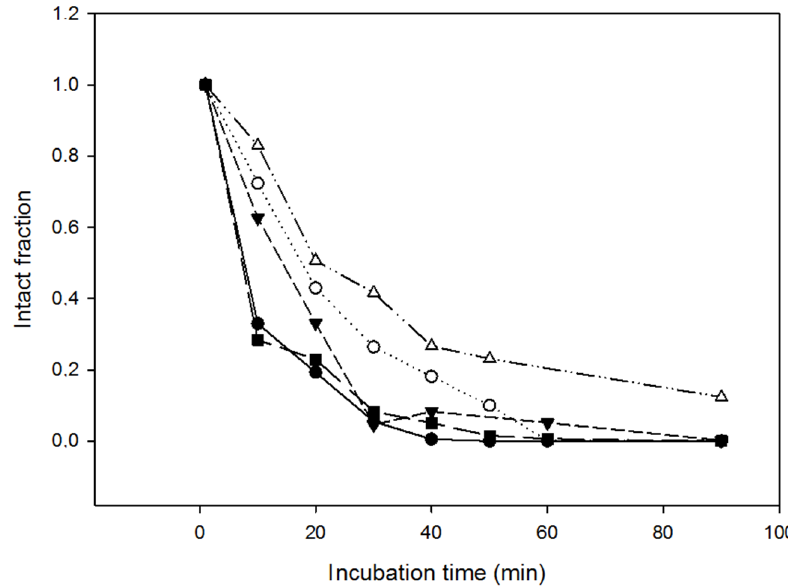
Figure 3. Resistance of the different ND-RNase variants to proteinase K. Amount of intact protein incubated in the presence of proteinase K at 37 °C throughout the incubation period. Symbols: NLSPE5 ( ); NLSPE5Cys1 ( ); NLSPE5Cys2 ( ▼ ); NLSPE5Cys3 ( Δ ); and NLSPE5Cys4 ( ).